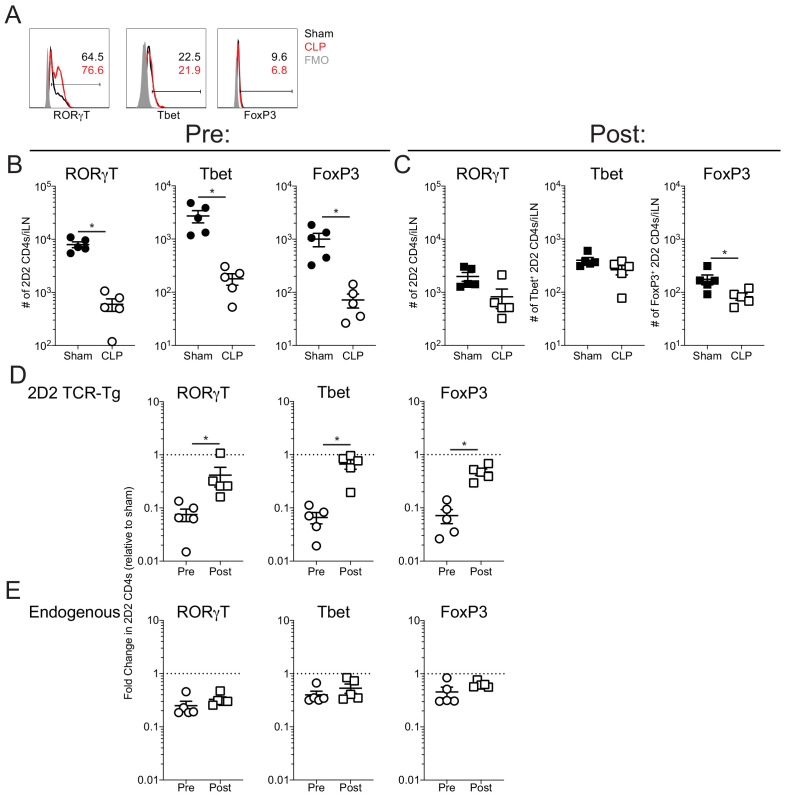
Sepsis does not influence the expression of RORγT, Tbet, and FoxP3 by autoantigen-specific T cells.Thy1.2 C57Bl/6 mice were separated into Pre- and Post-transfer groups. The Pre-transfer group received 5 × 103 naive Thy1.1 2D2 TCR-Tg CD4 T cells 1 day before sham or CLP surgery. The Post-transfer group underwent sham or CLP surgery then received 5 × 103 naive Thy1.1 2D2 TCR-Tg CD4 T cells 4 days later. EAE was induced in both the Pre- and Post-transfer groups 5 days after surgery (Pre: 6 days post 2D2 T cell transfer; Post: 1 day post 2D2 T cell transfer). iLN were harvested 7 days after the transfer. (A) Representative gating of RORγT, Tbet, and FoxP3 expression by 2D2 CD4s. Number of RORγT, Tbet, and FoxP3 2D2 CD4 T cells in pre- (B) and post-transfer (C) groups. Fold change in the number of RORγT, Tbet, and FoxP3 (D) 2D2 CD4 T cells and (E) endogenous CD4 T cells relative to sham controls in the pre- and post-transfer groups. Data are from 1 experiment with five mice per group. *p<0.05. Error bars represent the standard error of the mean.
Figure 6—figure supplement 2—source data 1.Source data for Figure 6—figure supplement 2.